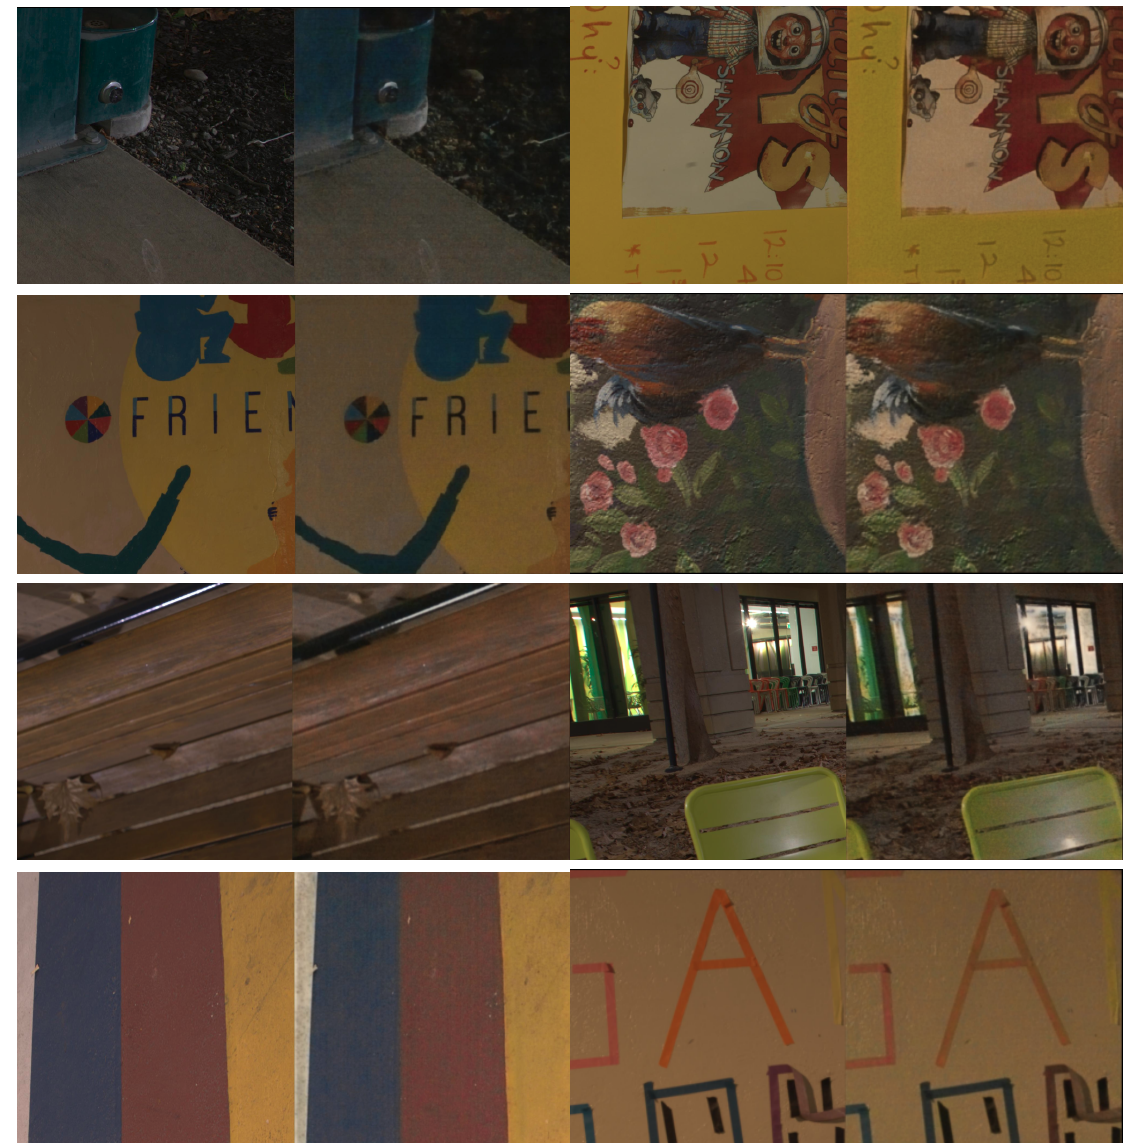
Figure 3. Training result with our converted dataset. On the left side is the ground truth image, and the right side is the result of training the image from a completely dark